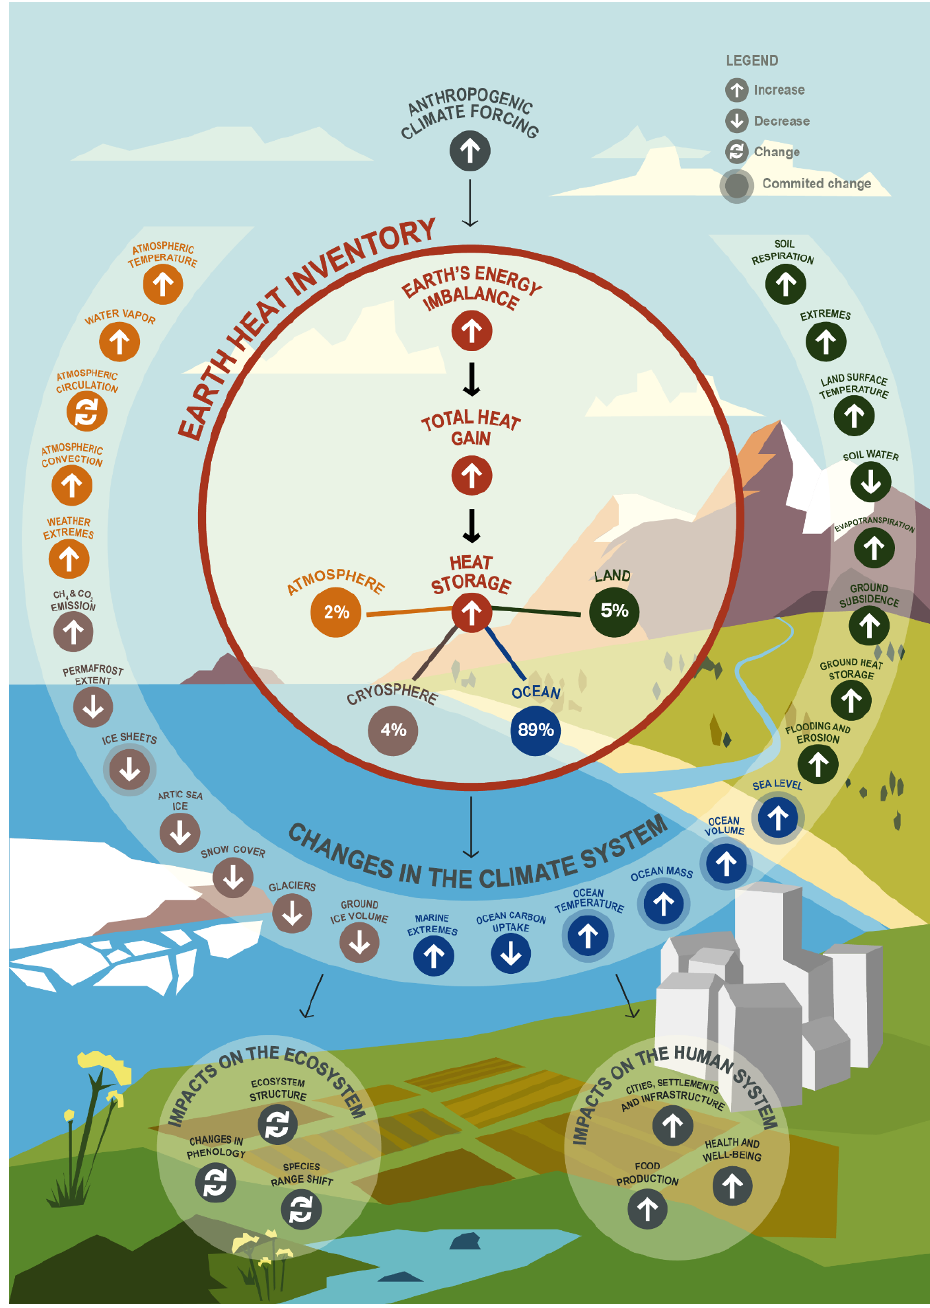
Figure 1. Schematic overview on the central role of the Earth heat inventory and its linkage to anthropogenic emissions, the Earth energy imbalance, change in the Earth system, and implications for ecosystems and human systems. The Earth heat inventory plays a central role for climate change monitoring as it provides information on the absolute value of the Earth energy imbalance, the total Earth system heat gain, and how much and where heat is stored in the different Earth system components. Examples of associated global-scale changes in the Earth system as assessed in Gulev et al. (2021) are drawn, together with major implications for the ecosystem and human systems (IPCC, 2022b). Upward arrows indicate increasing change, downward arrows indicate decreasing change, and turning arrows indicate change in both directions. The percentages for heat stored in the Earth system components are provided over the period 2006–2020 (see Sect.